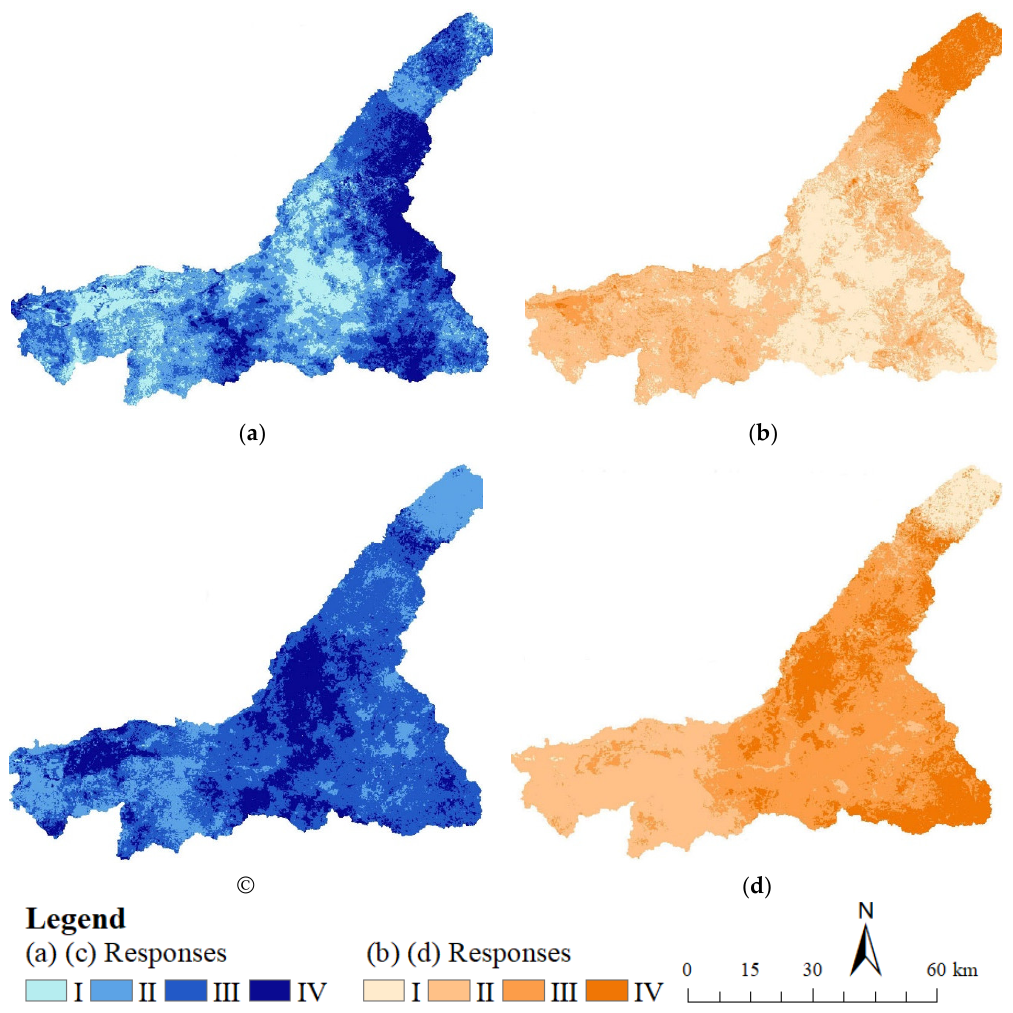
Figure 9. Responses of VG and VGT to climate factors in Mara River Basin in dry seasons: ( a ) responses of greenness to precipitation in dry seasons; ( b ) responses of greenness to temperature in dry seasons; ( c ) responses of greenness trend to precipitation in dry seasons; and ( d ) responses of greenness trend to temperature in dry seasons.